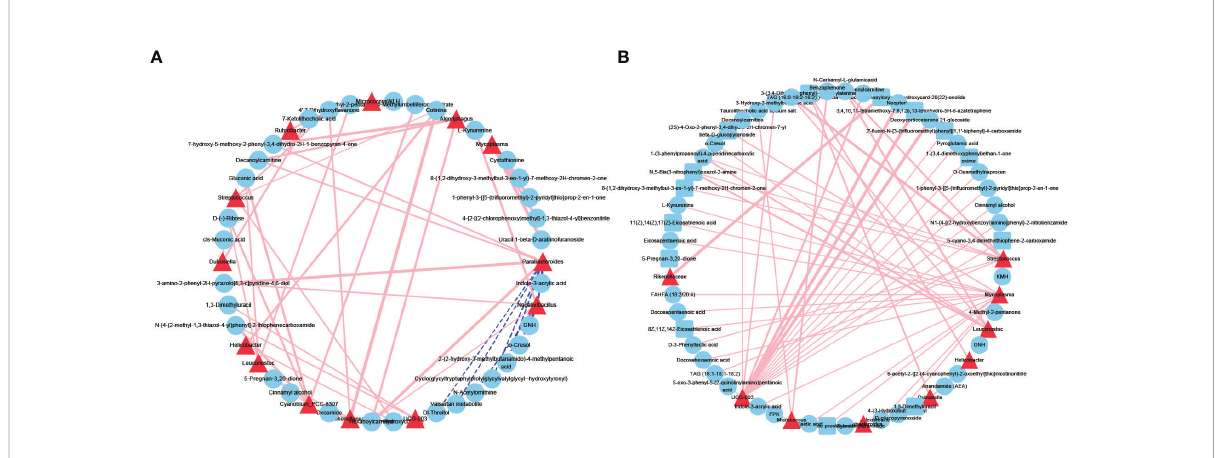
FIGURE 6 Network pro fi les between microbes and metabolites. (A) A network pro fi le of the normal control group. (B) A network pro fi le of the nephrolith group. Red line indicate positive correlations, dashed blue lines represent negative